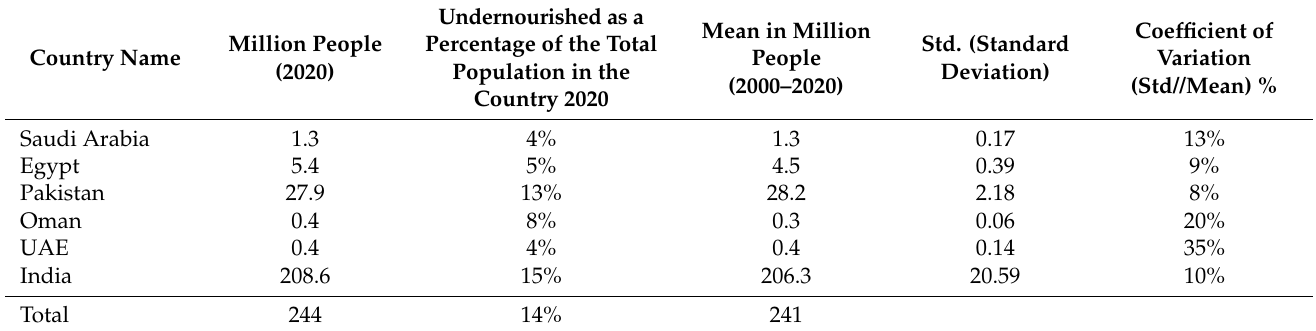
Table 4. Mean value of the number of undernourished people per million for the period 2000 to